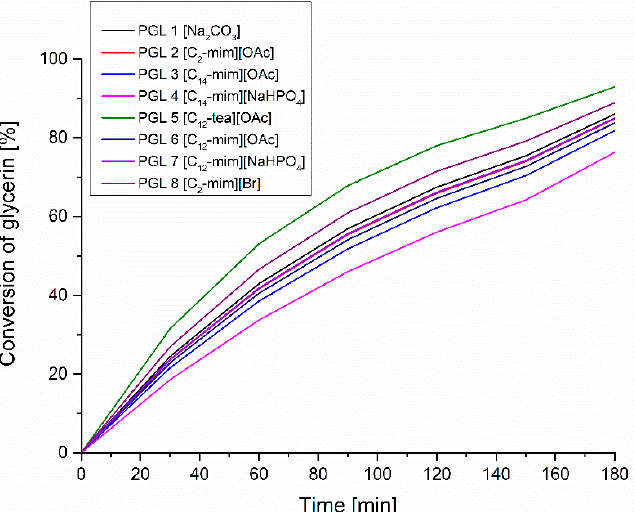
9 of 15 Figure 4. On-line monitored reaction spectra for glycerol oligomerization with [C 12 -mim][OAc].